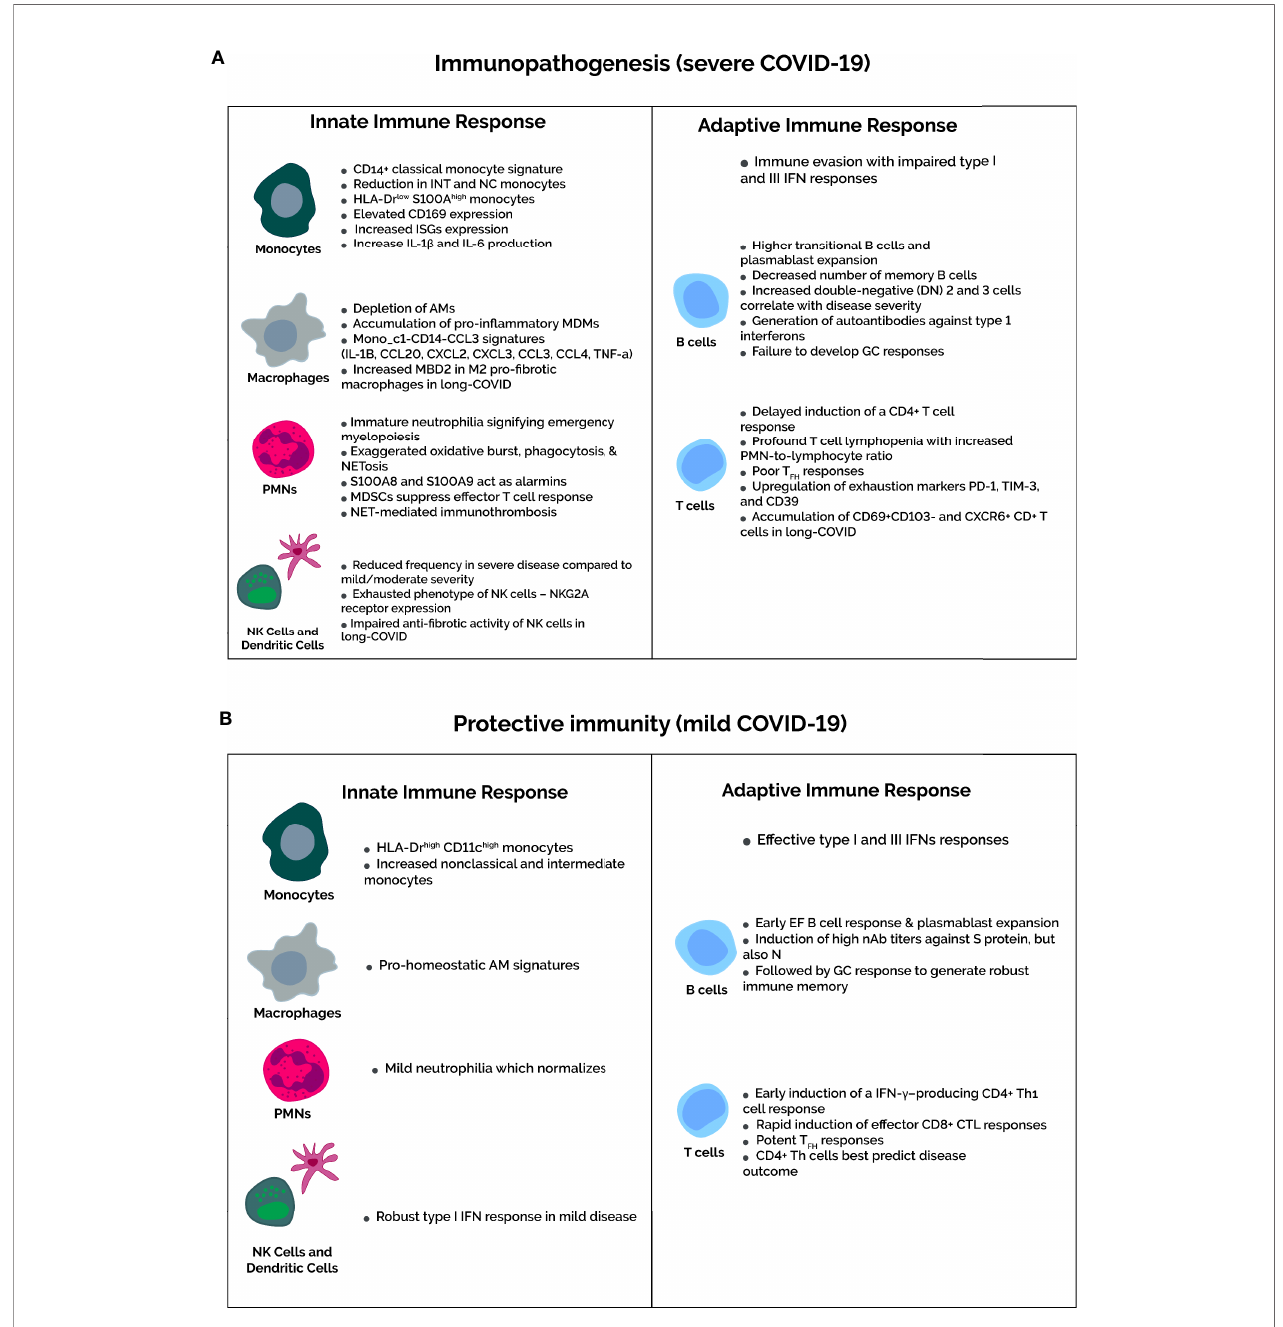
FIGURE 2 | Severity-dependent immune pro fi les upon SARS-CoV-2 infection. (A) In severe COVID-19, the immune evasion capabilities of SARS-CoV-2 inhibits IFN responses to delay the recruitment of functional T cells. Consequently, dysfunctional T cell immunity occurs in severe cases, marked by severe lymphopenia and higher expression of T cell exhaustion markers PD-1, TIM-3, and CD39. Not mentioned in the diagram is the increased number of Tregs in severe cases. Concomitantly, ampli fi cation of the innate response is characterized by accumulation of classical HLA-DR low S100A high proin fl ammatory monocytes and depletion of pro-homeostatic alveolar macrophages. Regarding neutrophils, an immature neutrophilia suggests emergency myelopoiesis, and neutrophil activation markers, such as oxidative burst, phagocytosis, and NETosis, increase in severe COVID-19. In addition, the MDSCs that contribute to the neutrophilia suppress T-cell responses and activate Tregs. Composition rather than quantity of the B cell compartment are altered in severe COVID-19, featuring more antibody-secreting plasmablasts and impaired germinal center responses with a decrease in memory B cells and T FH cells. (B) In contrast, mild COVID-19 infection is associated with recovery of T cell counts and function. The neutrophilia and HLA-DR expression on monocytes normalizes in mild cases. This is due to early induction of IFN responses upon SARS- CoV-2 infection, which elicits an effective and timely T-cell response. B cell compartment modi fi cations are as expected for viral infections, with potent early plasmablast responses and subsequent GC responses to yield long-lived SARS-CoV-2-speci fi c plasma and memory